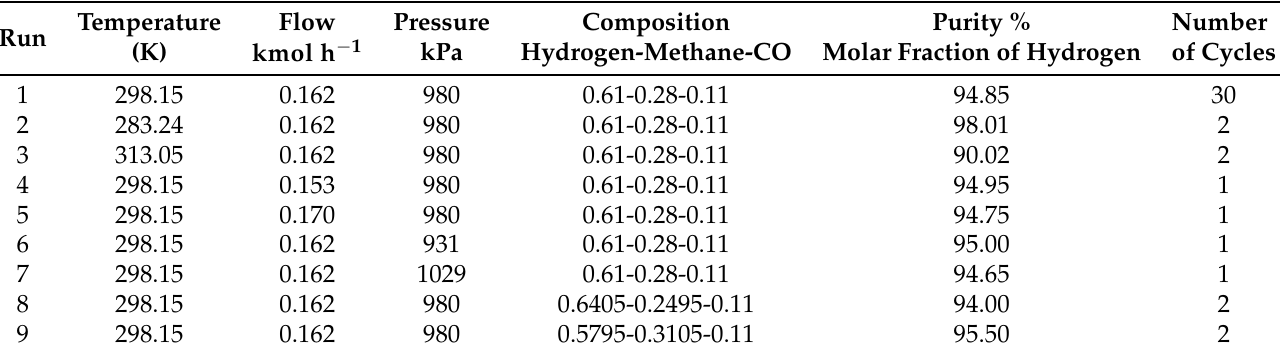
Table 2. Sensitivity analysis to define the control